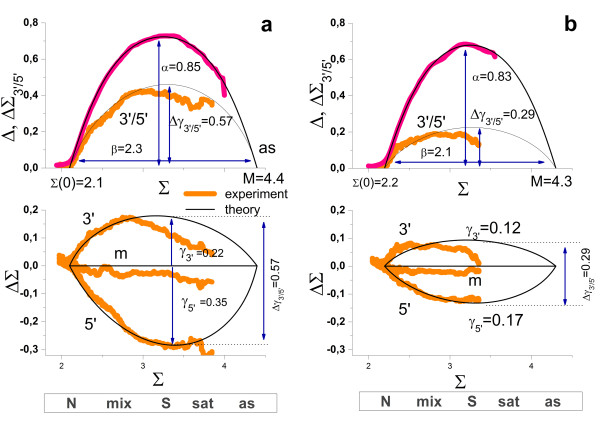
Hook- and degradation hook (above) and tongs-plot (below) of two selected chip hybridization taken form the human body index data set (muscle, GEO accession numbers GSM176301 in part a and skin, GSM175967 in part b) referring to large and smaller degradation effects, respectively. Note that all plots use the same abscissa scaling (Σ, see Eq. (7)) which is related to the expression degree of the respective probes. The hook curve reveals the changing hybridization mode with increasing sigma: non-specific (N), mixed N and S (mix), specific (S), saturation (sat) and asymptotic (as) ranges. The degradation hook and the tongs-plot reveal the mean 3′/5′-intensity bias of the probes. The three branches of the tongs plot refer to three probes nearest to the 3′-end (upper branch), nearest to the 5′-end (lower branch) and located in the middle in-between (middle branch). Note that the different branches split maximally in the S-range of hybridization whereas no bias is observed in the N-range as predicted by theory (lines, see Eqs. (16) and (21) for the hook and tongs plot, respectively). The theoretical curves are calculated using the formulae given in the methodical section using the parameters given in the figure. The hook dimensions (α, ‘height’ of the hook, see Eq. (18); β, ‘width’ of the hook; Σ(0), ‘start’ point; M, ‘end’-point) are very similar for both arrays whereas the logarithmic 3′- and 5′-degradation levels (Eq. (24)) are markedly different. The size of the moving window is decreased towards the right end of the tongs plot to compensate the reduced number of probe sets in saturation range. As a consequence, the part of the curves beyond of the maximum is prone to increasing error